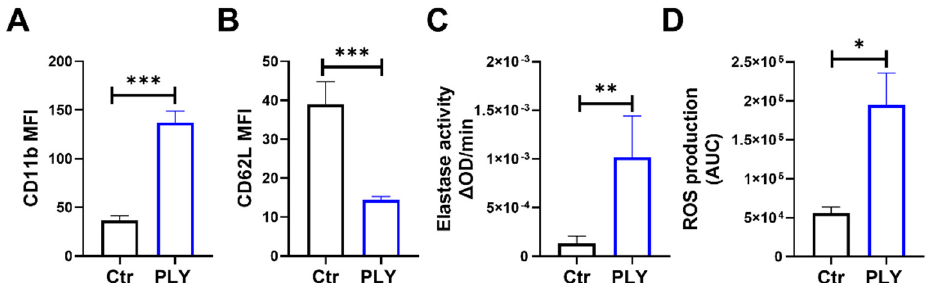
Figure 1. Pneumolysin (PLY) induces neutrophil activation. Human neutrophils were treated with PLY (100 ng/mL, 30 min) and cell surface expression (MFI) of ( A ) CD11b or ( B ) CD62L was assessed using flow cytometry. ( C ) Elastase activity was determined in cell culture supernatants. ( D ) ROS production was measured using a luminol based kinetic assay. Bars represent area under the curve (AUC) values calculated from kinetic curves. n = 5–9. * p < 0.05, ** p < 0.01, *** p < 0.001, t -test.